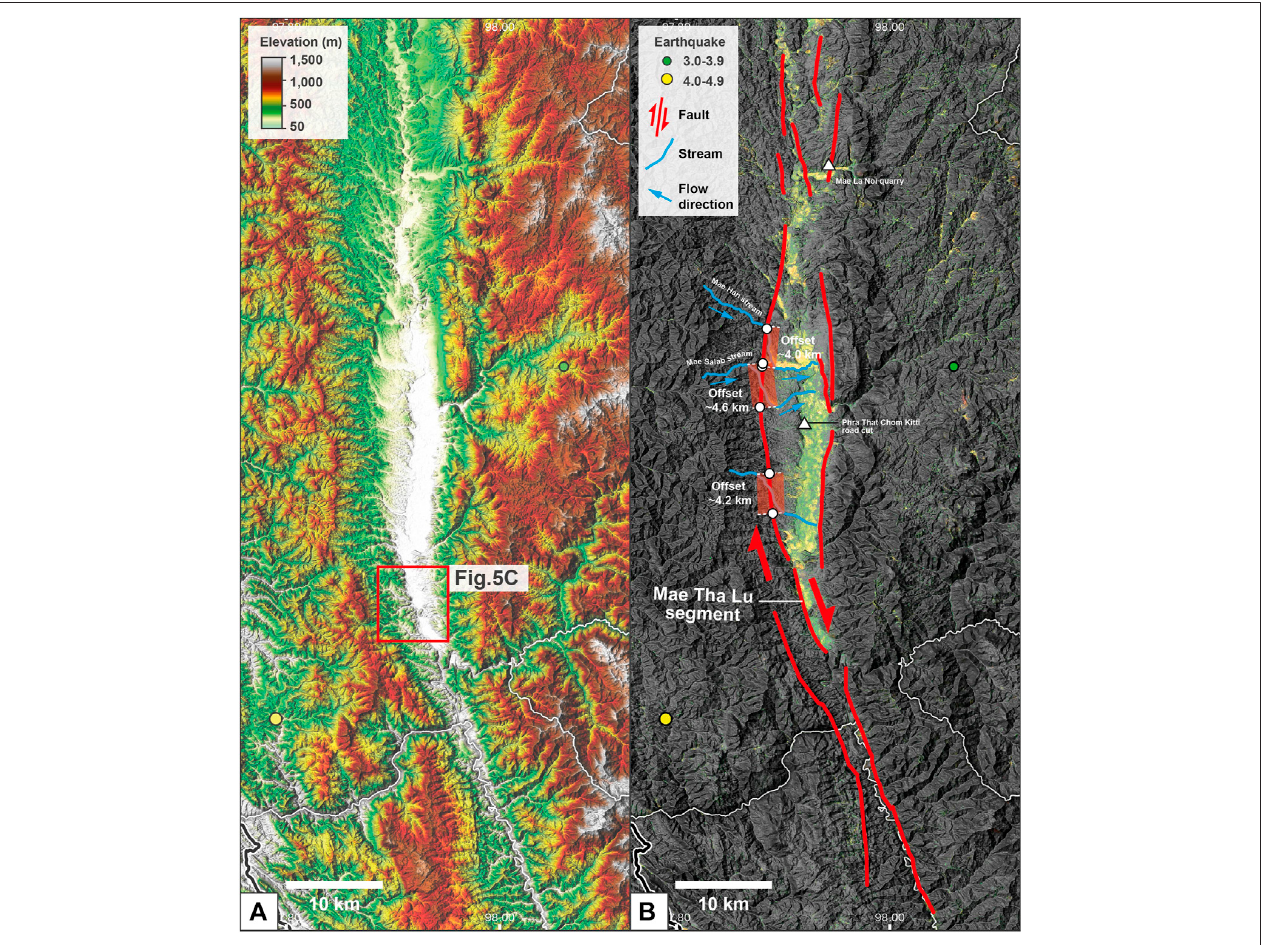
FIGURE4| MaeSariangBasinonthesouthoftheMaeHongSonProvinceshows (A) enhancedALOSDEM,and (B) detailedinterpretationattheMaeHanstream displays offset stream with maximum offset of ~4.0 km suggesting the right lateral strike-slip fault movement and at the Mae Salab stream shows the offset stream of ~4.6 km suggesting the dextral movement. Locations are shown in Figure 2A .